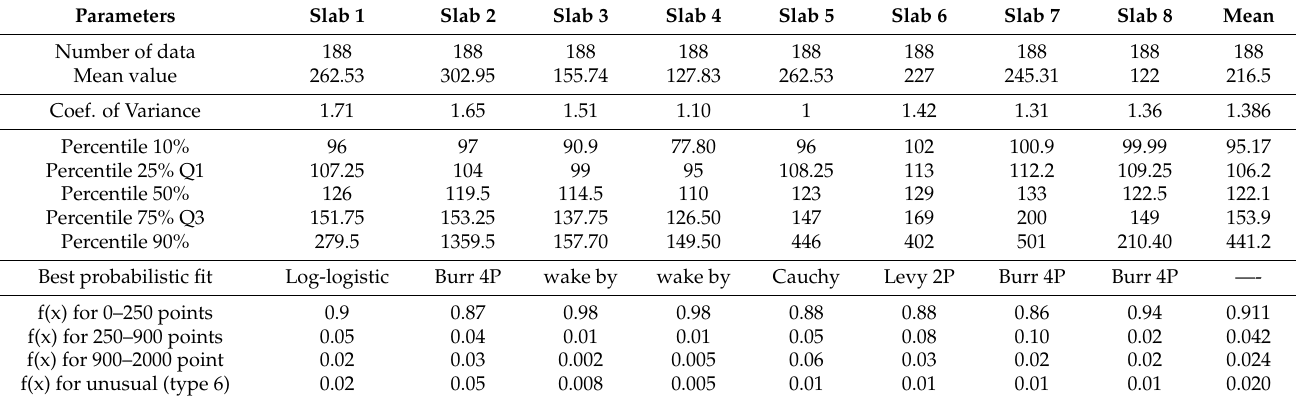
Table 2. Probability result for preprocessed IE signals based on signal length for sound